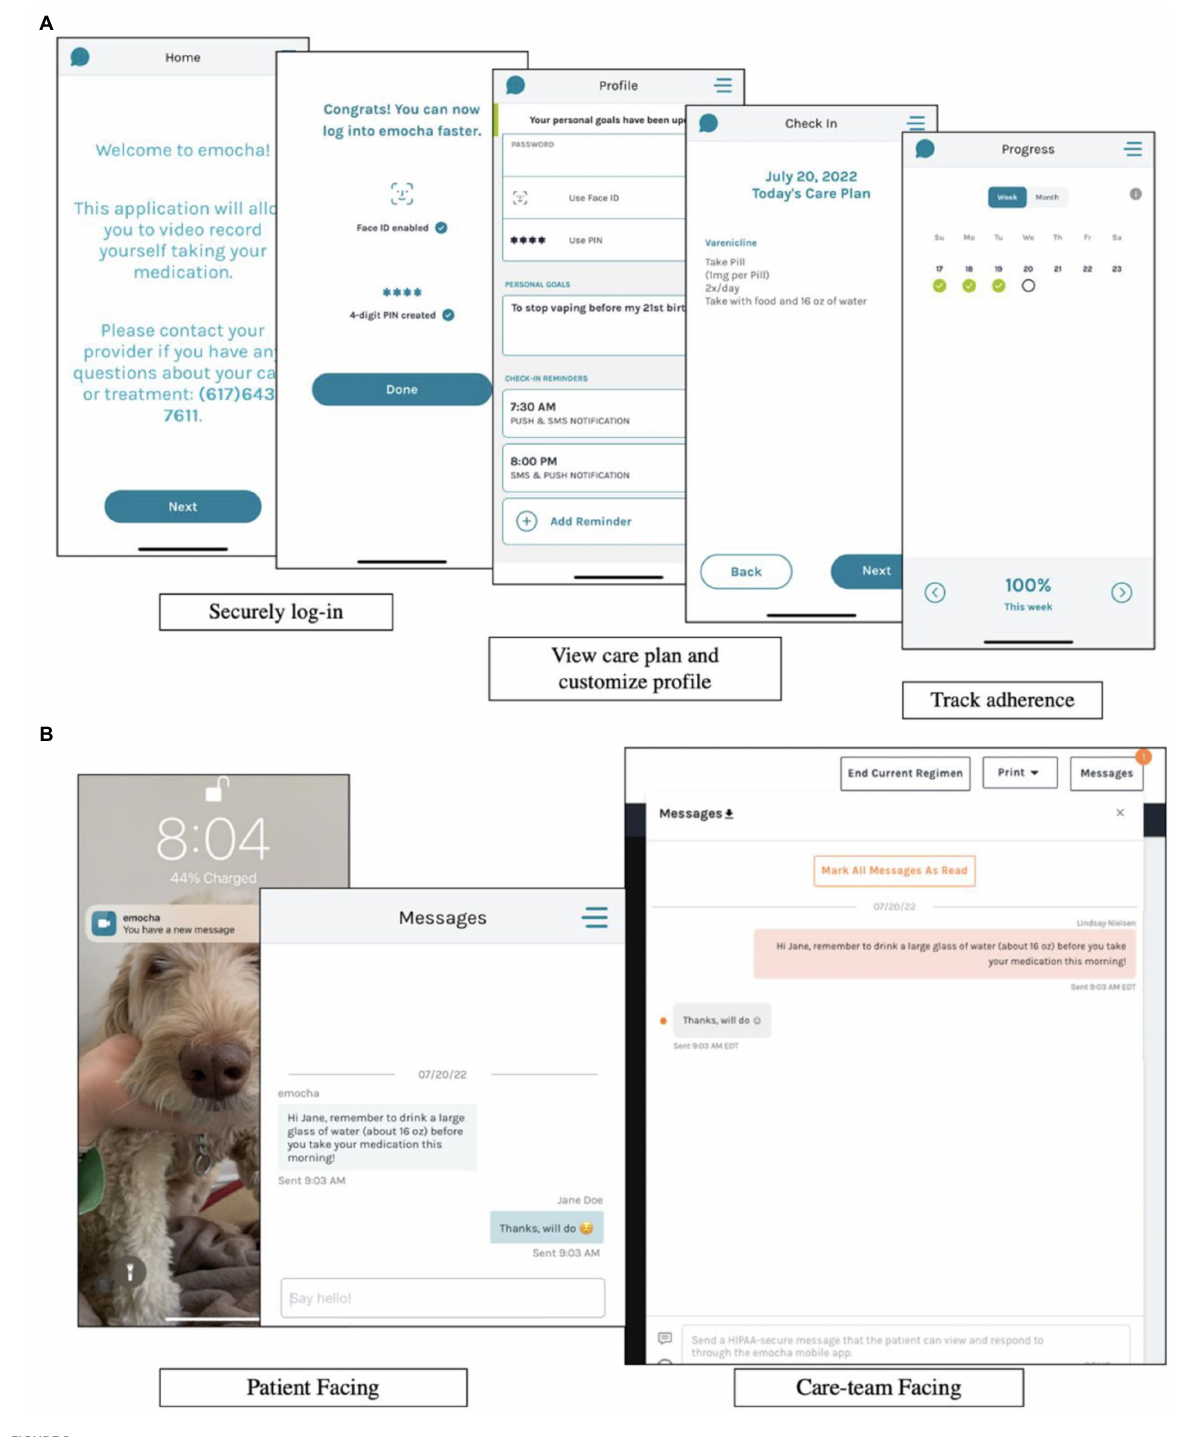
FIGURE 2 Information regarding emocha, a HIPAA-compliant mobile phone application used for medication adherence. (A) Demonstrates how participants are able to securely log in to emocha, view their medication schedule for the day, and track their medication adherence. (B) Demonstrates how participants receive phone notifications from emocha, as well as how participants can message study staff securely through the